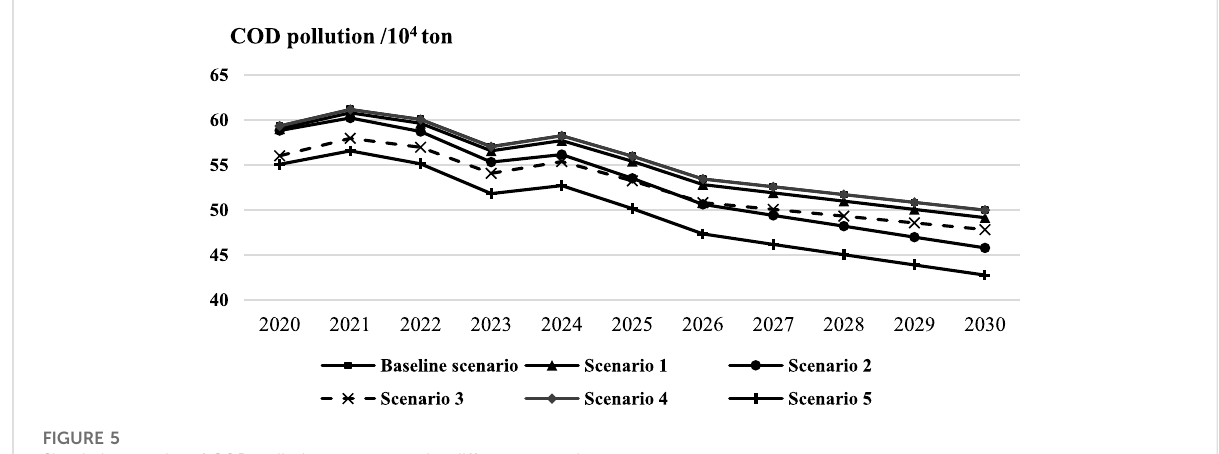
Simulation results of COD pollution amount under different